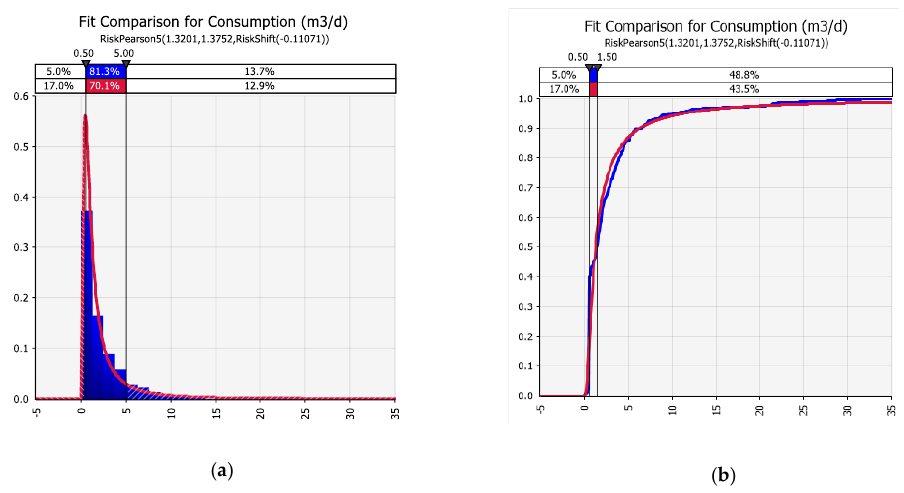
Figure 5. Water consumption in the study area, ( a ) probability density graph, ( b ) cumulative density graph (drawn using licensed version of @Risk Version 8 software). Horizontal axis shows water consumption (m 3 /day) and vertical axis represents probability values. Input data are shown in blue color and red line represents the Pearson 5 distribution.